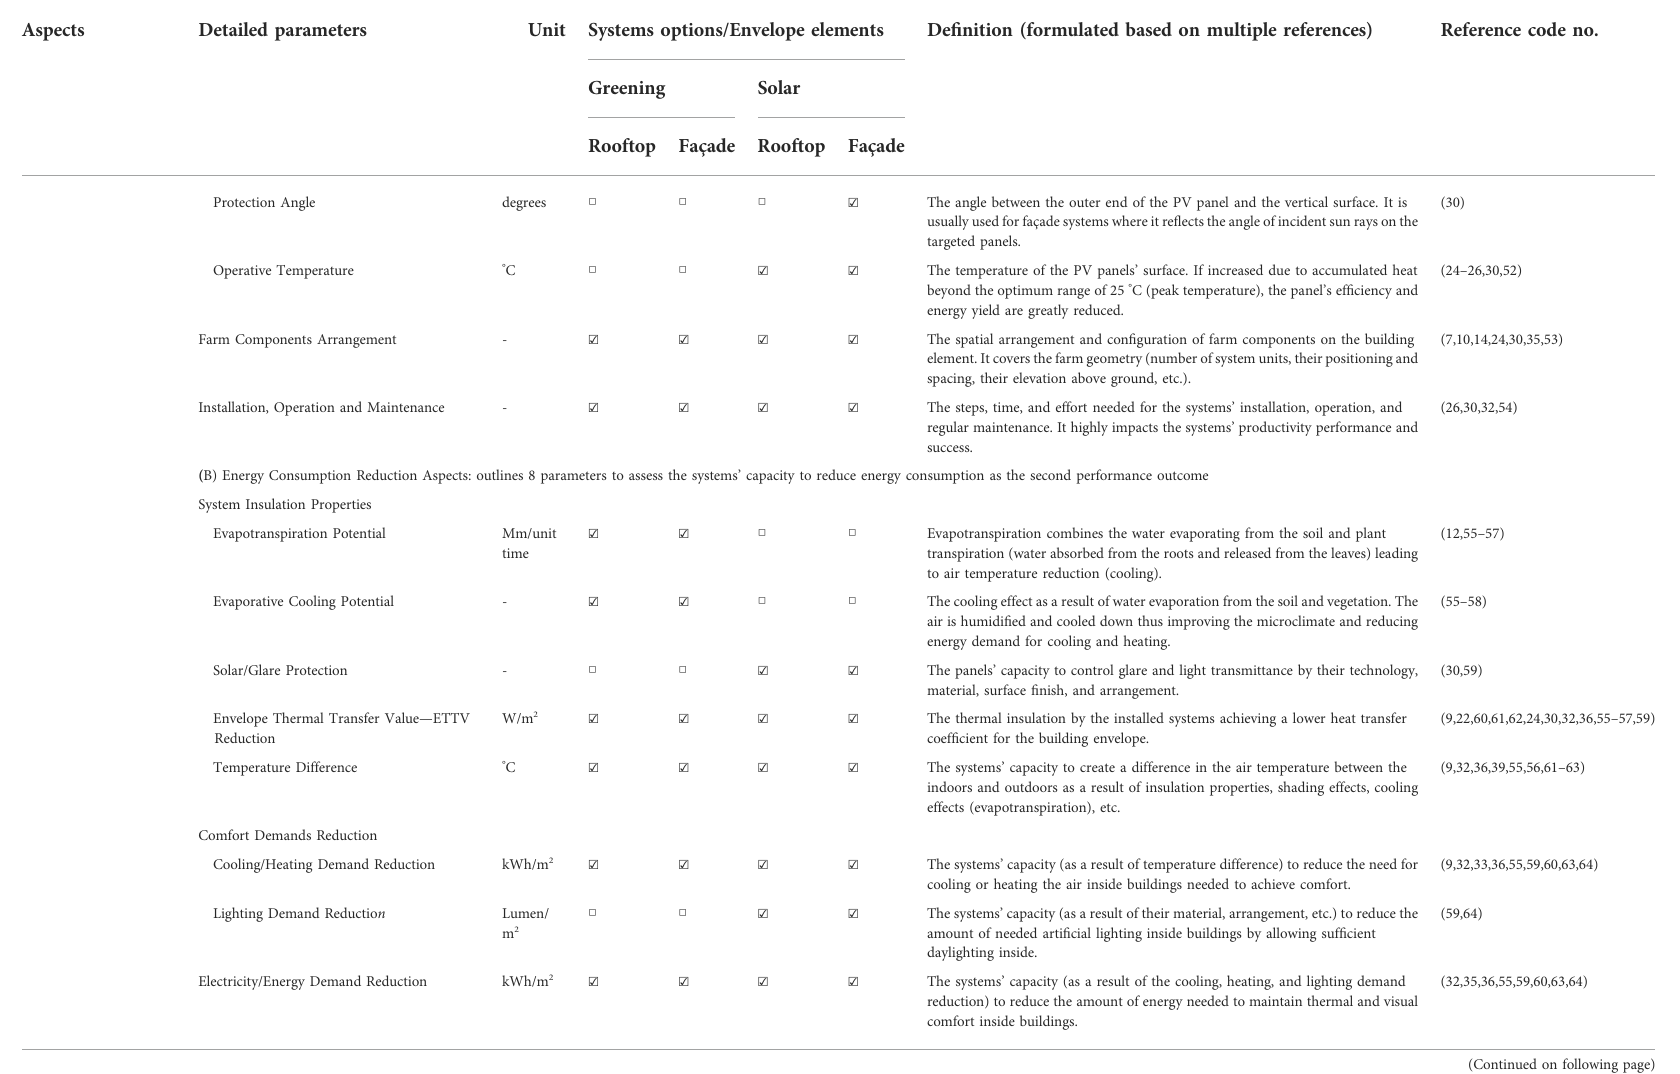
TABLE 2 ( Continued ) Pillar 2 of performance aspects for PBSs Implementation mapped against systems ’ options (greening or solar) on different envelope elements (rooftop or façade). Detailed aspects and parameters were de fi ned for each category, the measurement units, and the de fi nitions are outlined as well. DLI, Daily Light Integral; LAI, Leaf Area Index; PAR, Photosynthetically Active Radiation; CWR, Crop Water Requirements; PVs, Photovoltaic panels; ETTV, Envelope Thermal Transfer Value.